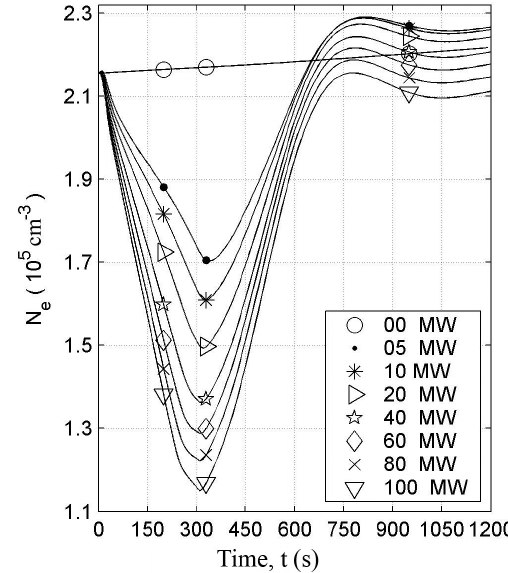
Fig. 4. The time variations of the electron concentration (in units of 10 5 cm − 3 ) at the level h = 410km. The results are given for the same cases as in Fig.